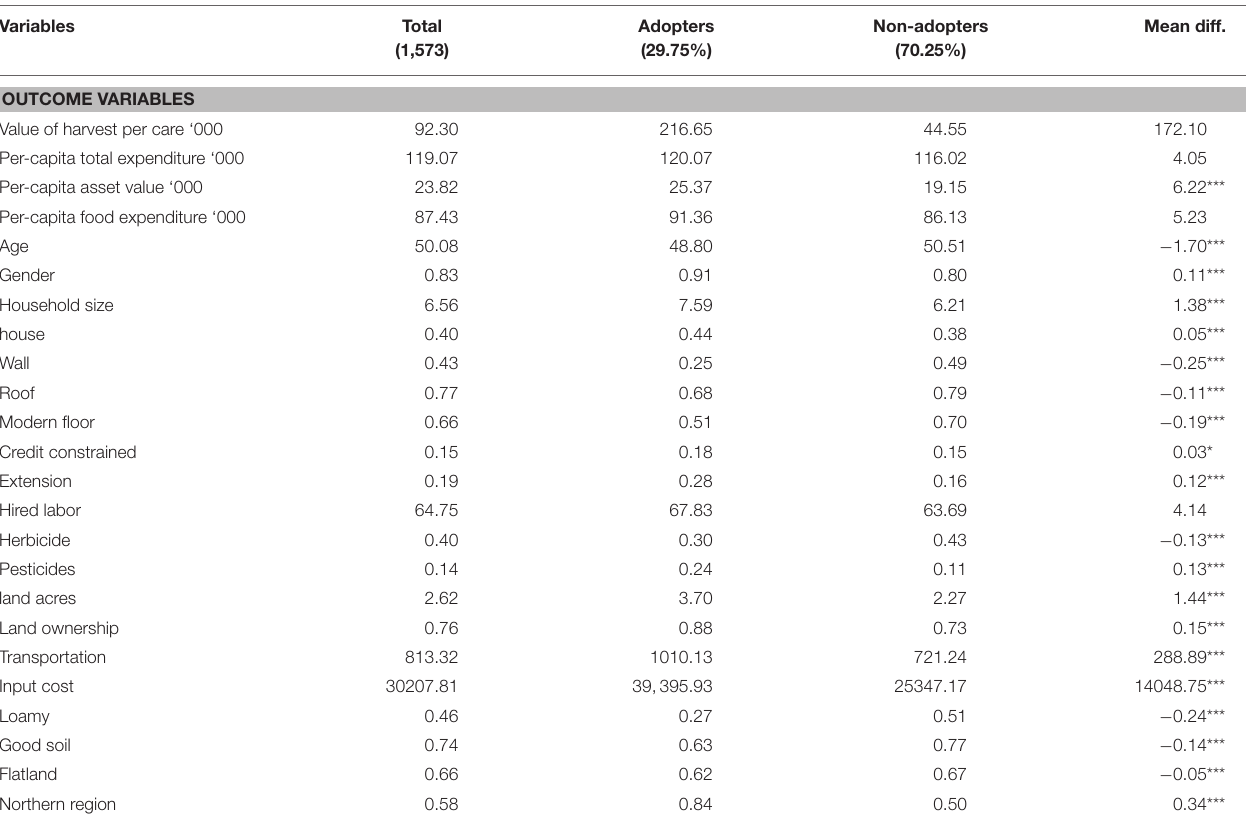
TABLE 2 | Summary statistics of agricultural households attributes by adoption status. Variables Total